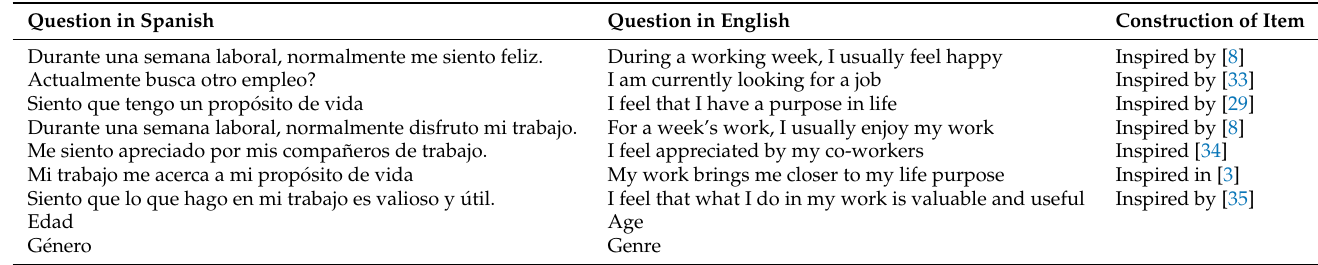
Table A1. Questionnaire used in meaningful